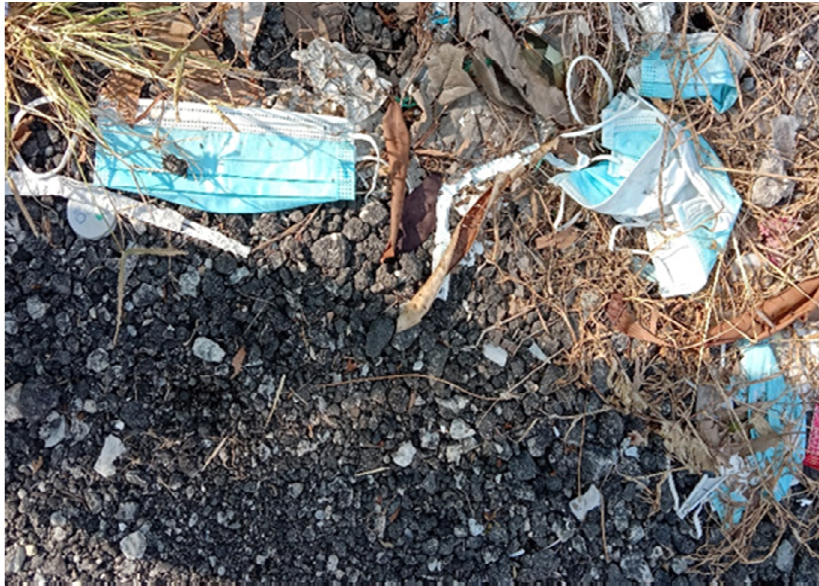
Figure 1. Used surgical masks that were not properly disposed.